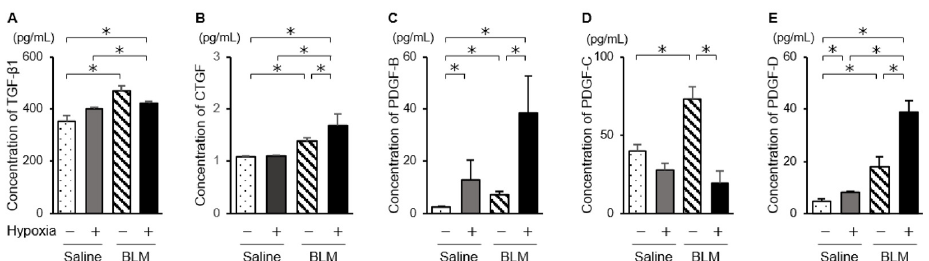
Figure 2. Expression of mediators, determined by quantitative real-time PCR. mRNA levels of var- ious mediators were compared between endothelial cells from saline- and bleomycin-treated mouse lungs. Quantitative real-time PCR was performed using three independently prepared cDNA sam- ples from endothelial cells harvested from saline- or bleomycin-treated lungs on day 7. Results were normalized to expression levels in endothelial cells from untreated lungs at day 0. Data are means ± standard error of the mean for three mice. * p < 0.05.